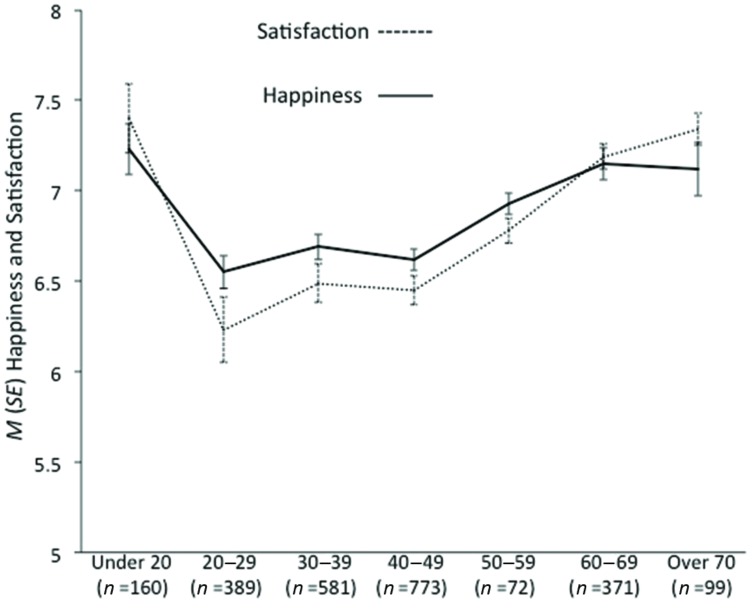
M (SE) happiness and satisfaction levels by age category.